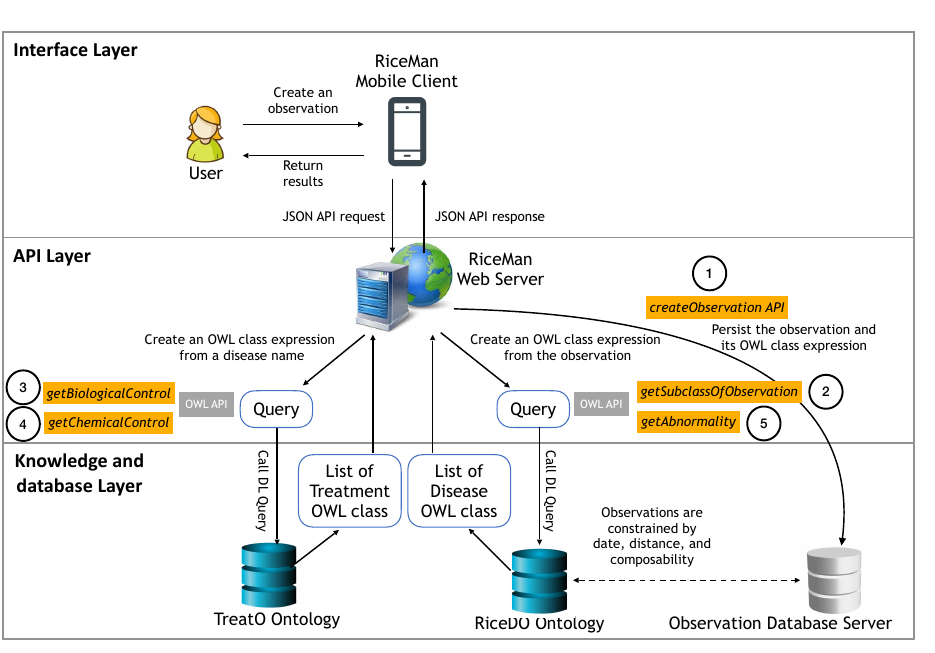
Figure 4. The RiceMan system architecture classified into three layers: (1) interface layer which indicates the client side’s environment; (2) API layer with five main APIs; and (3) knowledge and database layer, which contains our two ontologies and their